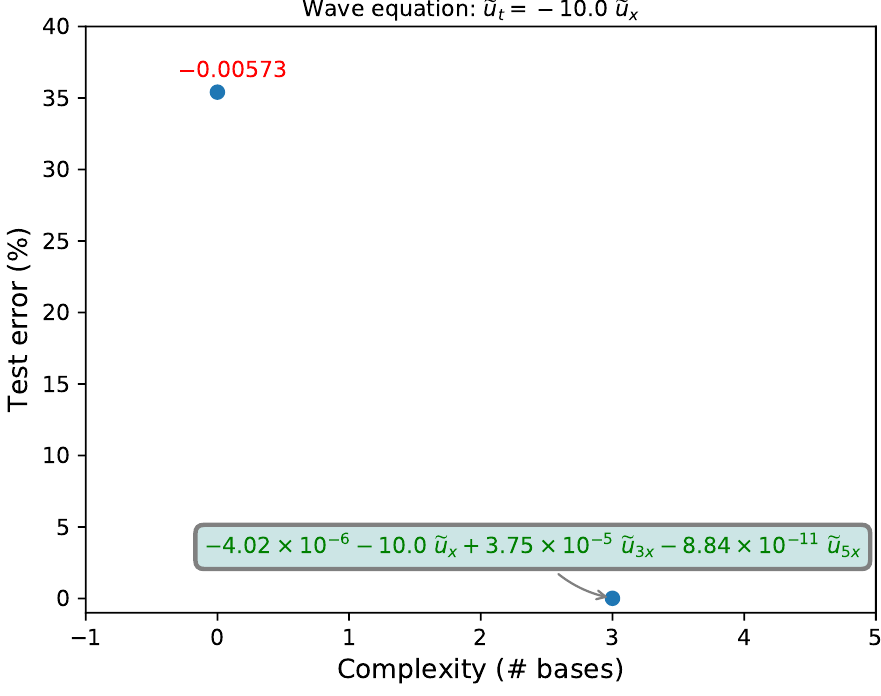
Figure 2. Non-dimensional analytical solution of wave equation.